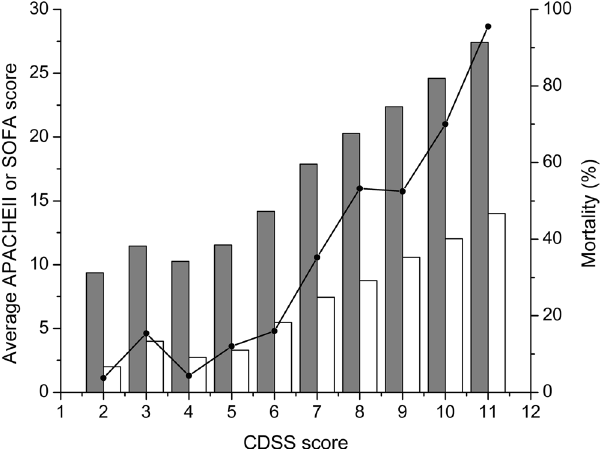
Figure 2. Corellations between the CDSS score and the APACHE II score, the SOFA score as well as the 28-day all-cause mortality. With the increase of the Chinese Disseminated Intravascular Coagulation Scoring System (CDSS) score on the day of diagnosis, average Acute Physiology and Chronic Health Evaluation (APACHE) II score (white bars), average Sequential Organ Failure Assesssment (SOFA) score (gray bars) and the 28-day all- cause mortality (line) of the patients increased